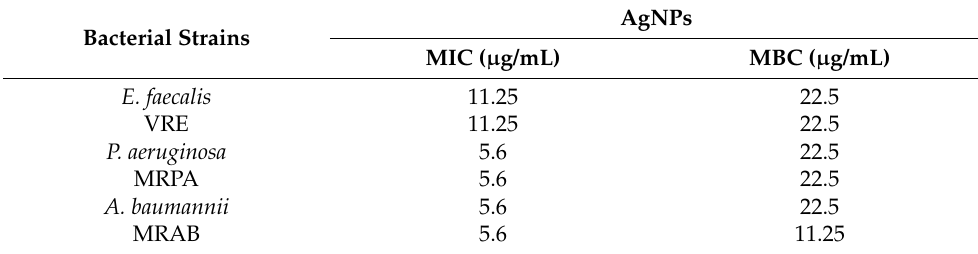
Table 6. Minimum inhibitory concentration (MIC) and minimum bactericidal concentration (MBC) results of AgNPs using A. catechu against 6 strains of